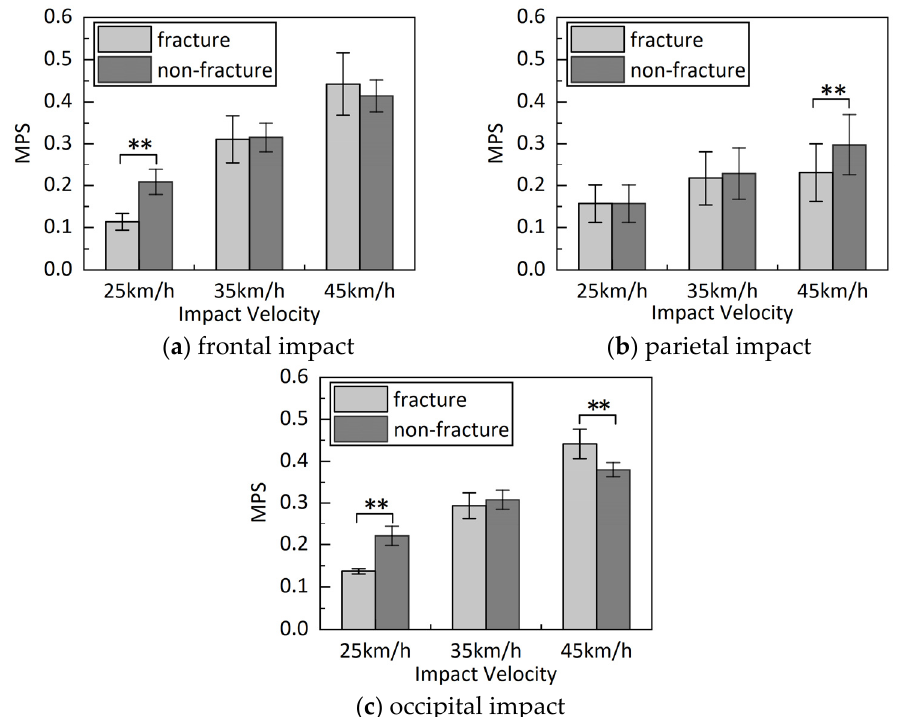
Figure 12. Average peak MPS from the impact region of three impact models under three impact velocities. Shown are the average and standard deviations of peak MPS response of 18 elements in the selected region. Asterisks on fracture and non-fracture models indicate the significant level of skull fracture effect on MPS peaks at each velocity; * denotes significant effect, that is, 0.01 < p ≤ 0.05; ** denotes extremely significant effect, that is, p ≤ 0.01. ( a ) frontal impact ( b ) parietal impact ( c ) occipital impact.